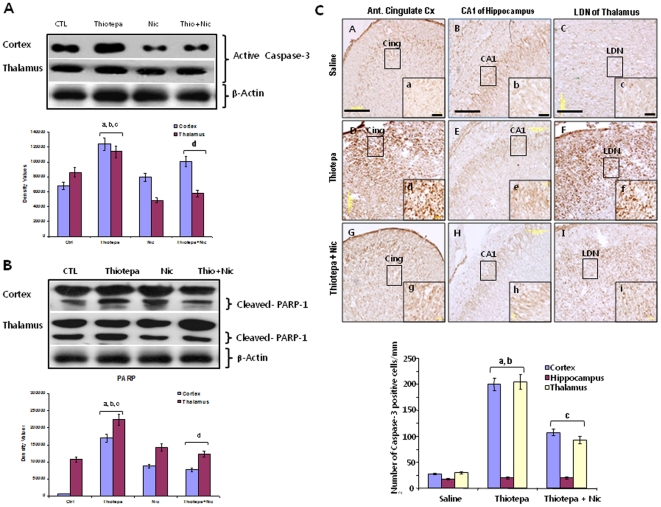
Co-treatment effect of nicotinamide on thiotepa-induced expression of active caspase-3 and cleavage of PARP-1.(A) Representative Western blot analysis of cleaved caspase-3 levels in the cortex and thalamus of rats. Thiotepa administration resulted in a significantly enhanced level of expression of active caspase-3. Treatment with nicotinamide significantly reduced thiotepa-induced activated caspase-3 levels in both cortex and thalamus as compared to control group. Detailed procedures are described in the Materials and Methods section. The protein bands of Western blots were quantified using Sigma gel software, and their differences are represented in the graph. Actin reactivity was used as a protein loading control. Density values, expressed as mean ± SEM (n = 5–6 animals/group), of the caspase-3 protein are presented. The density values on the Y-axis are expressed as arbitrary units (AU). Statistical difference was determined using one-way analysis of variance (ANOVA) followed by Student's t-test. (aSignificantly different from CTL, [cortex P<0.05 and thalamus P<0.05]; bSignificantly different from Nicotinamide, [cortex P<0.05 and thalamus P<0.01]; cSignificantly different from Thiotepa + Nicotinamide, [cortex P<0.05 and thalamus P<0.05]; dSignificantly different from Thiotepa, [cortex P<0.05 and thalamus P<0.05]). (B) Representative Western blot analysis of cleaved PARP-1 levels in the cortex and thalamus of rats. Thiotepa administration resulted in significantly enhanced expression levels of active caspase-3, and caspase-3 mediated a high level of cleaved 89-kDa apoptosis-related fragment of PARP-1. As shown, treatment with nicotinamide significantly reduced thiotepa-induced activated caspase-3 and cleaved PARP-1 levels in both the cortex and thalamus when compared to control group. Density values, expressed as mean ± SEM (n = 5–6 animals/group), for 89 Kda caspase-3 cleaved PARP-1 proteins are presented. Statistical difference was determined using one-way analysis of variance (ANOVA) followed by Student's t-test. (aSignificantly different from CTL, [cortex P<0.001 and thalamus P<0.01]; bSignificantly different from Nicotinamide, [cortex P<0.01 and thalamus P<0.05]; cSignificantly different from Thiotepa + Nicotinamide, [cortex P<0.01 and thalamus P<0.05]; dSignificantly different from Thiotepa, [cortex P<0.01 and thalamus P<0.05]). (C) Representative Photomicrographs showing immunohistochemical analysis 24 h after treatment with 30 mg/kg thiotepa in the absence or presence of nicotinamide. Light micrographs show active caspase-3-positive neurons in cingulate cortex and LDN of thalamus (Dd and Ff) after thiotepa treatment, but none in hippocampus (Ee). The arrows indicate dead neuronal cells with high active caspase-3 expression. Treatment of nicotinamide (1 mg/g) with thiotepa resulted in a marked reduction in the number of active caspase-positive neurons in the cortex and thalamus (Gg and Ii) compared to controls (Aa and Cc). Images are representative of staining obtained in sections (3–5/group) prepared from at least 5–6 animals/group. (a–i = 40×) are magnified views from panels (A–I = 20×), Scale bar = 50 µm. Statistical difference was determined using one-way analysis of variance (ANOVA) followed by Student's t-test. (aSignificantly different from CTL, [cortex P<0.001 and thalamus P<0.001]; bSignificantly different from Thiotepa + Nicotinamide, [cortex P<0.05 and thalamus P<0.01]; cSignificantly different from Thiotepa, [cortex P<0.01 and thalamus P<0.01]).